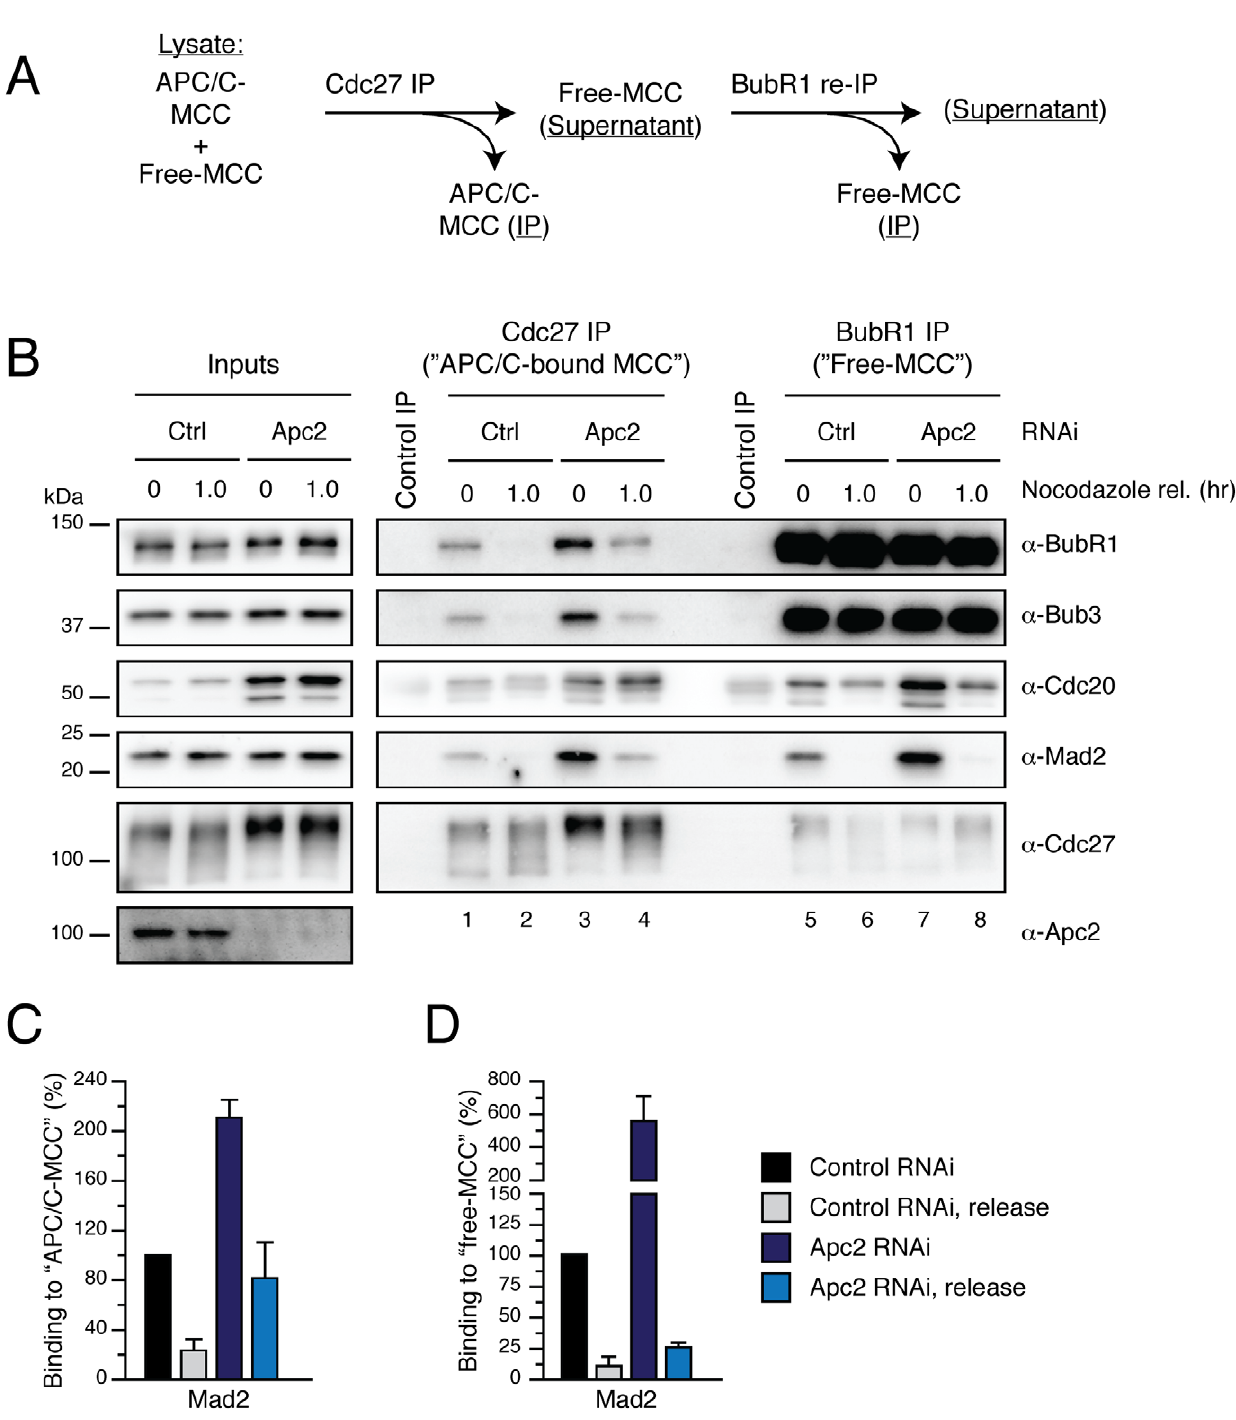
Figure 7. APC/C activity is required for MCC disassembly independently of proteolysis. ( A ) Timeline showing the experimental strategy. ( B ) Immunoblots of BubR1 immunocomplexes isolated from mitotic HeLa cells depleted of p31 comet or Apc2 by RNAi, arrested in mitosis with nocodazole and released into media containing MG132, ZM447439 and AZ3146. Cyclin A was used as a marker for lack of APC/C activity. ( C ) Bar graph quantifying the experiment in (B). Values represent the mean 6 s.e.m. of four independent experiments.